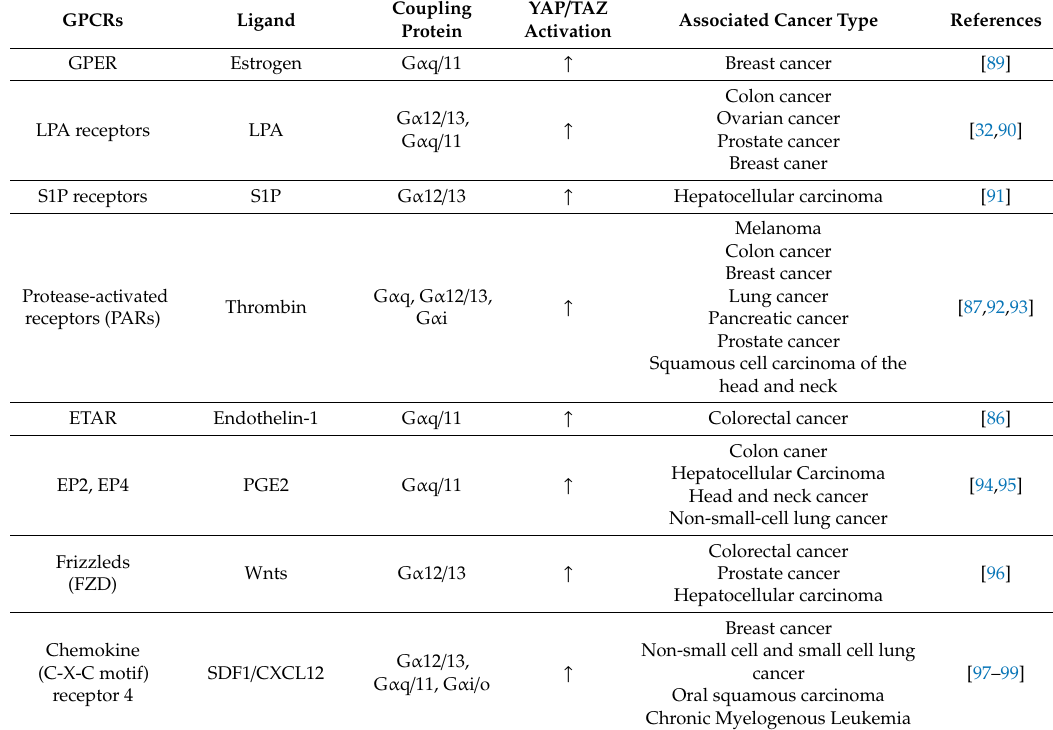
Table 1. The regulation of YAP / TAZ activity by various G-protein coupled receptors in human cancers. Representative GPCRs that are most frequently implicated in human cancer are shown and their regulation on YAP / TAZ activation are listed in the following